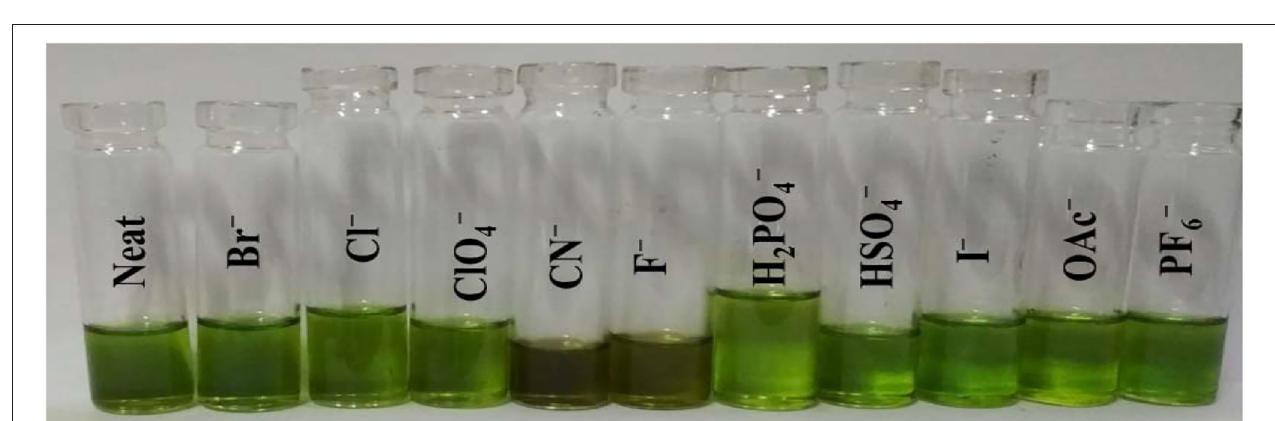
FIGURE 4 | Colorimetric response of 1 using 4 equiv. of various anions in CH 2 Cl 2 at 298K.